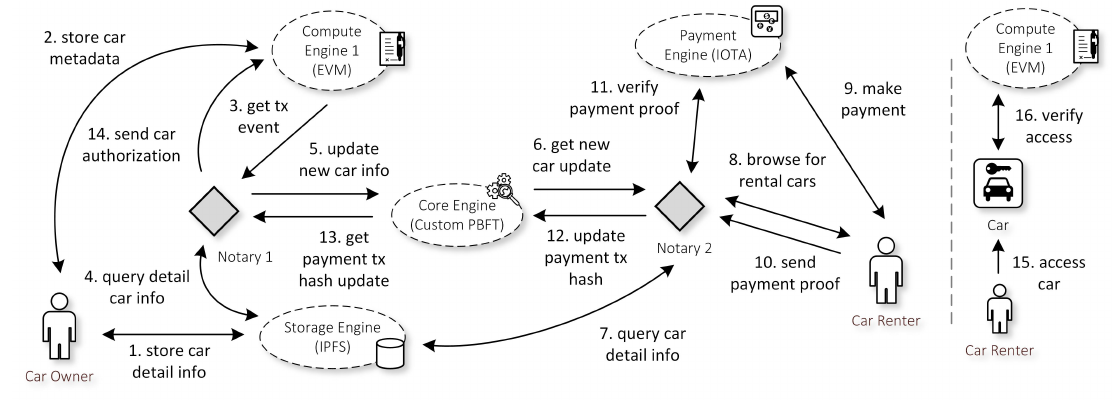
Figure 6. The use case of an IoT car rental application, tailored to run in our proposed